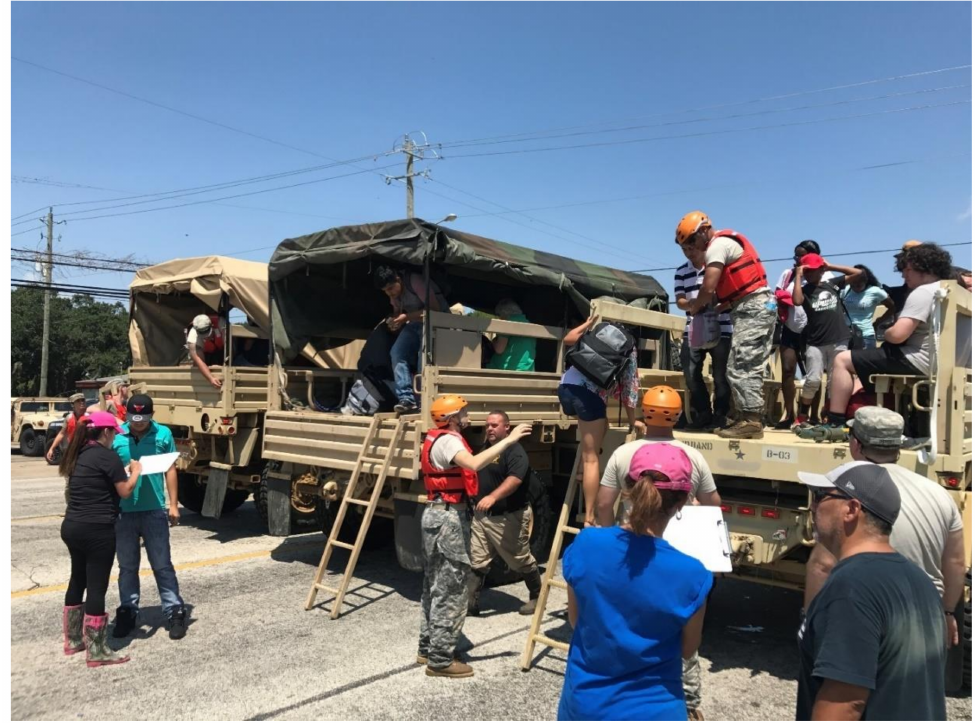
Figure 1. US military assists with appropriate protective equipment for flood response during the Hurricane Harvey response (photo credit: Wharton City Police